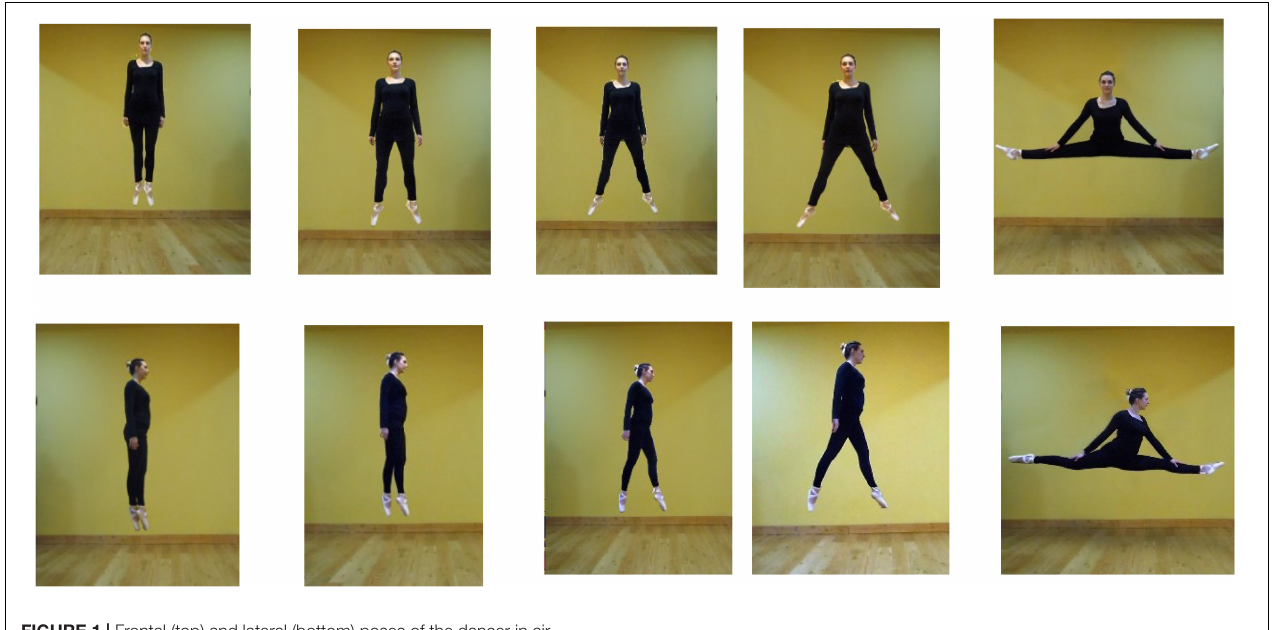
FIGURE 1 | Frontal (top) and lateral (bottom) poses of the dancer in air.